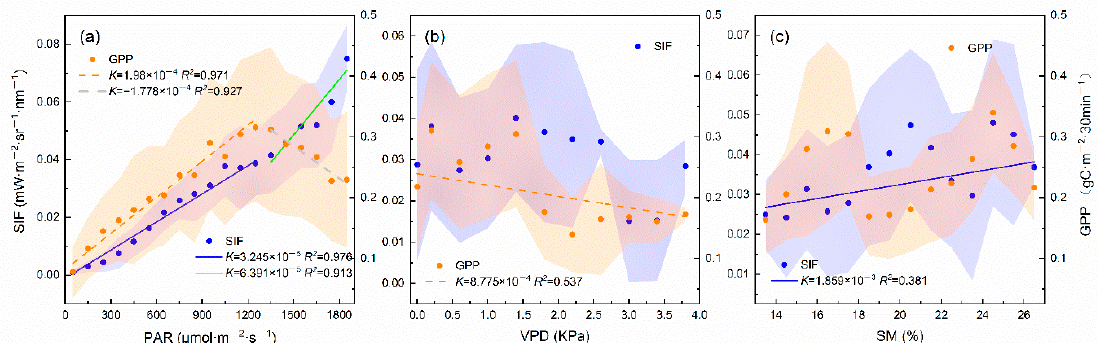
Figure 5. The response of SIF-GPP to different meteorological factors in the 30 min timescale, ( a ), ( b ) and ( c ) represent PAR, VPD and SM, respectively. The solid line and dashed line represent the linear fit between SIF and GPP with meteorological factors, respectively. K and R 2 represent the fitting slope and regression coefficients, respectively. All data are for sunny days.